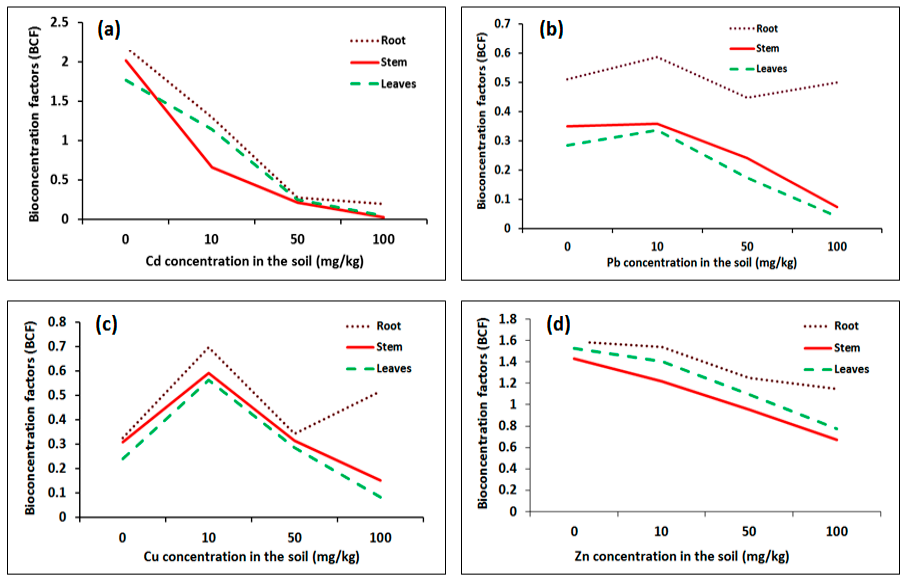
Figure 7. Bioconcentration factor (BCF) of Rhazya stricta plant organs grown in soil treated with heavy metal treatments of 10, 50 and 100 mg/kg soil in an open greenhouse. ( a ) BCF of Rhazya stricta plant organs in soil treated with Cd, ( b ) BCF of Rhazya stricta plant organs in soil treated with Pb, ( c ) BCF of Rhazya stricta plant organs in soil treated with Cu, ( d ) BCF of Rhazya stricta plant organs in soil treated with Zn.